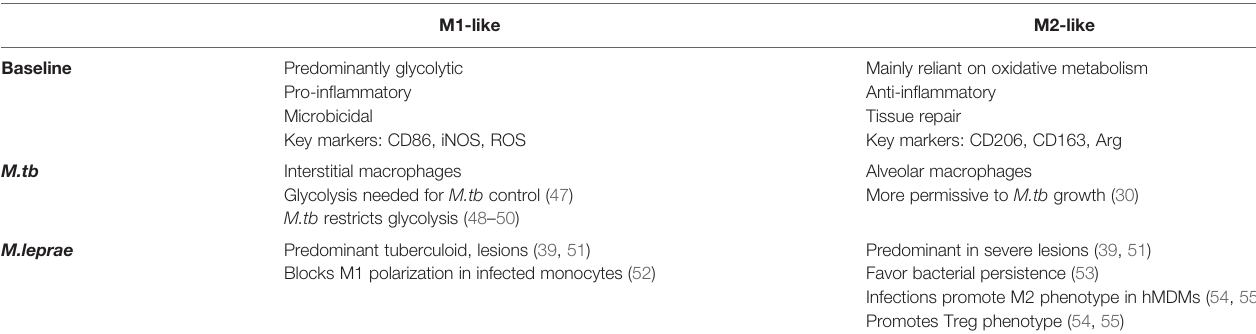
Tissue repair Key markers: CD206, CD163,